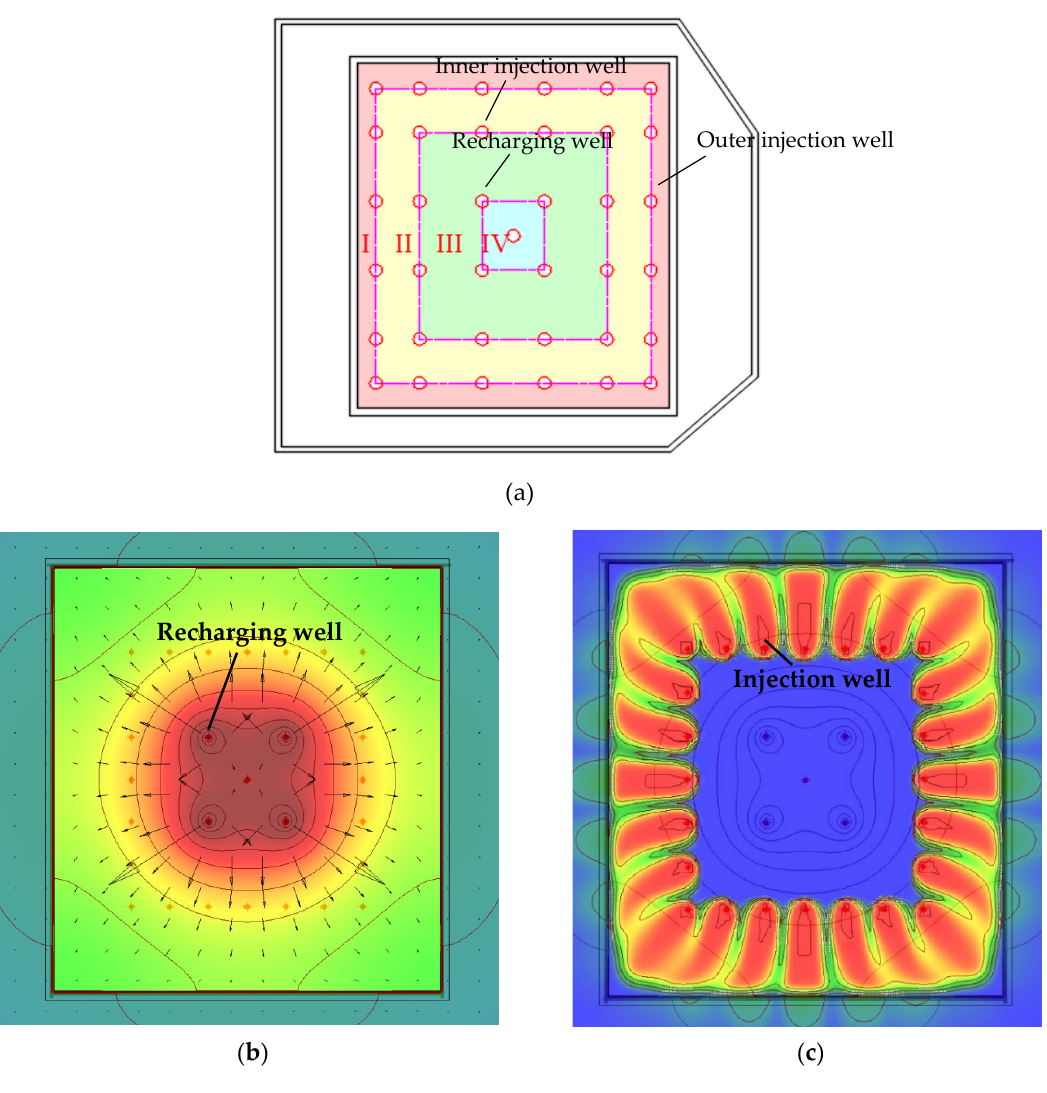
Figure 3. MICP HSRB formation method: ( a ) Layout of recharging and injection wells; ( b ) Steady seepage field formed by recharging well; ( c ) Outer circle bacteria solution driven by seepage field. (2) Booster pumps were used to form a stable seepage field, as shown in Figure